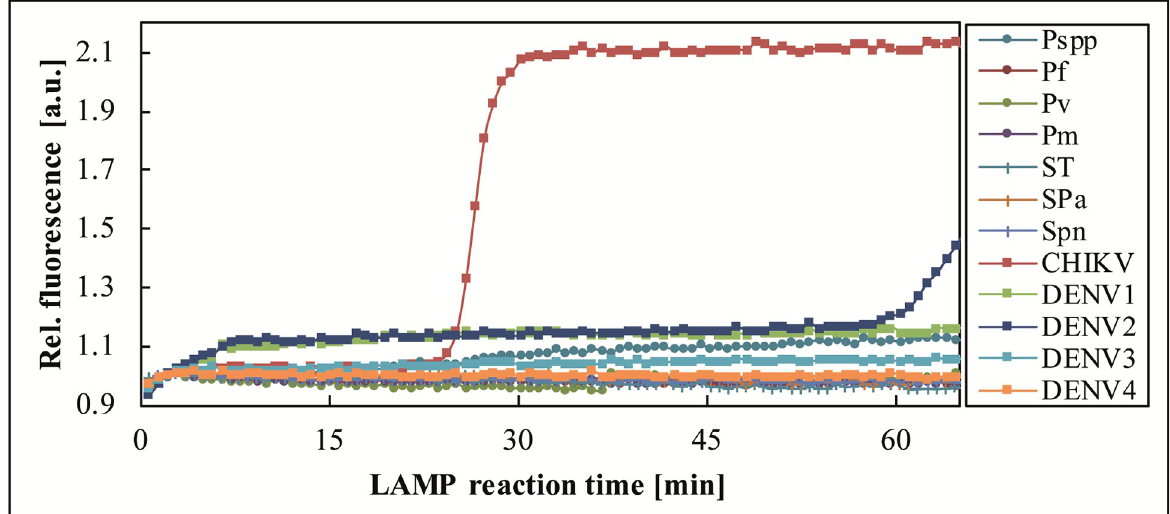
Fig 4. Detection of CHIKV and DENV2 co-infection in sample 274754. The FeverDisk showed a true positive DENV2 amplification in addition to the CHIKV-expected amplification.